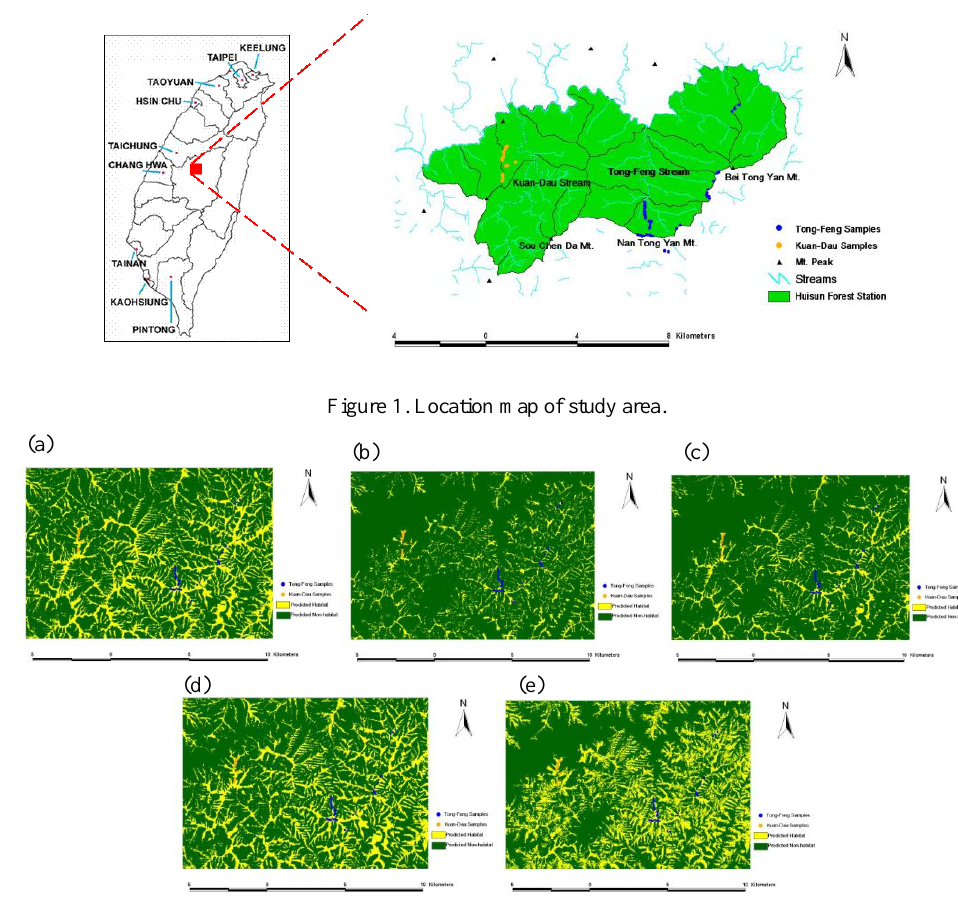
Figure 2. Predicted distribution maps of SD3 included (a) DA, (b) DT, (c) MAXENT, (d) ML, and (e)